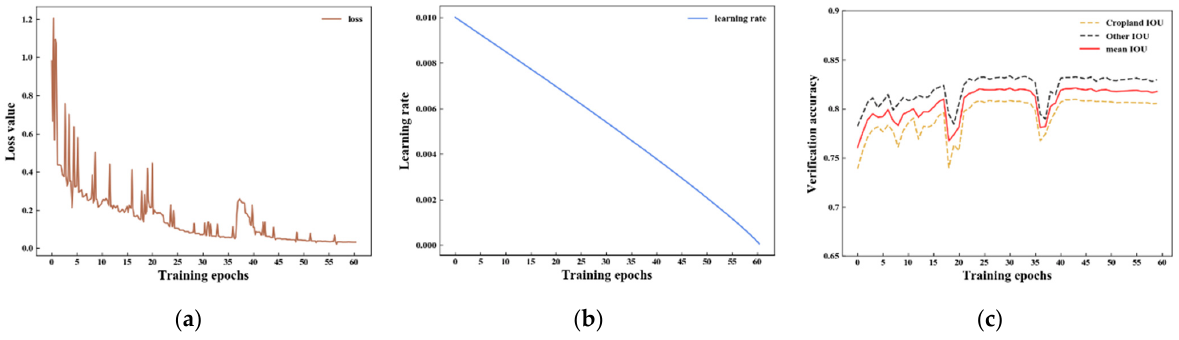
Figure 10. The training diagram of the cropland extraction network in GID data: ( a ) the decreasing curve of training loss, ( b ) the learning rate curve, and ( c ) the validation set accuracy curve.